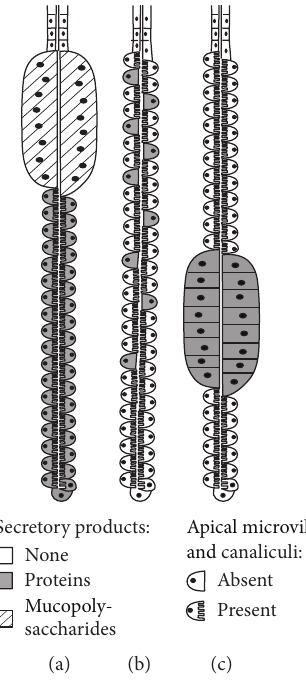
Figure 7: General organization of the Malpighian tubules in Cicad- omorpha. The most basal parts, hidden inside the filter chamber, are not shown. (a) Immature Cercopoidea and Cicadoidea. (b) Mapuchea chilensis . (c) Cicadellidae and